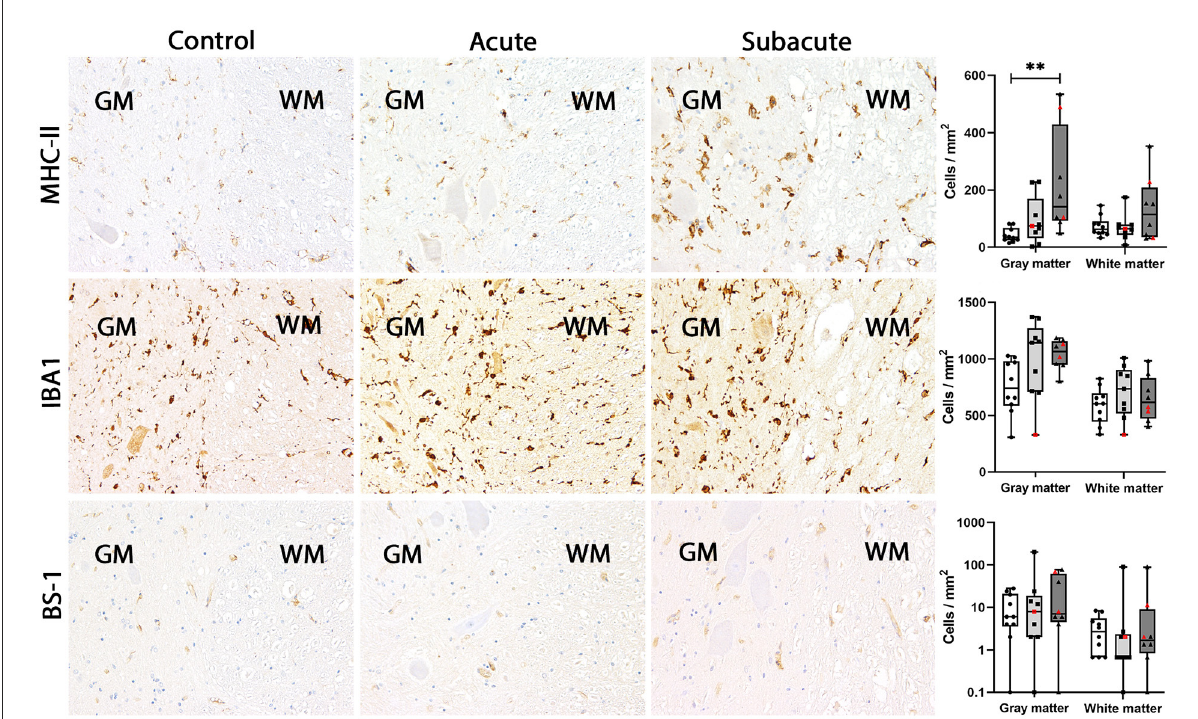
FIGURE3 MHC-II, IBA1 and BS-1 expression in the canine spinal cord. In control dogs, low numbers of microglia/macrophages expressed MHC-II in gray and white matter. No change in MHC-II expression was found in dogs with acute spinal cord injury (SCI). In dogs with subacute SCI, the number of MHC-II-positive cells increased significantly in gray matter only. IBA1 is expressed by a high number of microglia/macrophages in gray and white matter of control dogs. This number did not change significantly in dogs with acute and subacute SCI. Only few BS-1-positive cells were present in gray and white matter of control dogs. This number stayed at low levels in dogs with acute and subacute SCI. Immunohistochemistry using the avidin-biotin complex immunoperoxidase method. Shown are box plots with all data points (red: cervical SCI; black: thoracolumbar SCI). Kruskal-Wallis test: ** p <